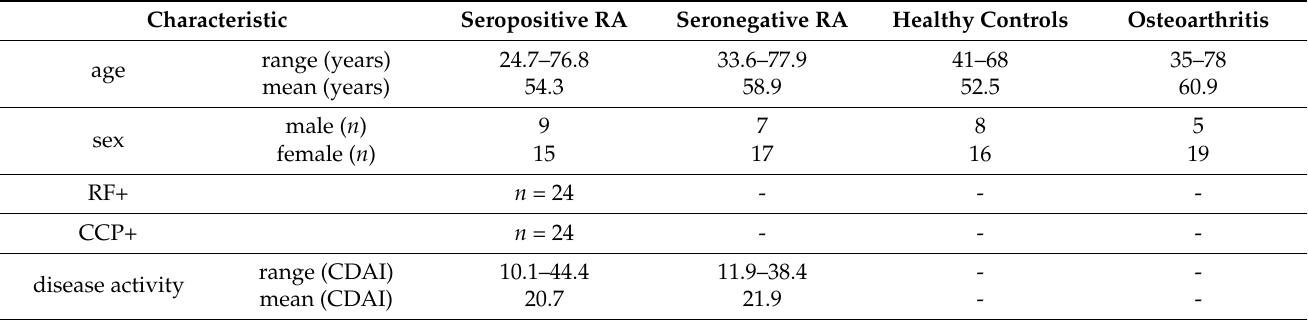
Table 5. Sample characteristics of the investigated human cohort: age, biological sex, rheumatoid factor (RF), ACPA (CCP+) status and disease activity as clinical disease activity status (CDAI) are